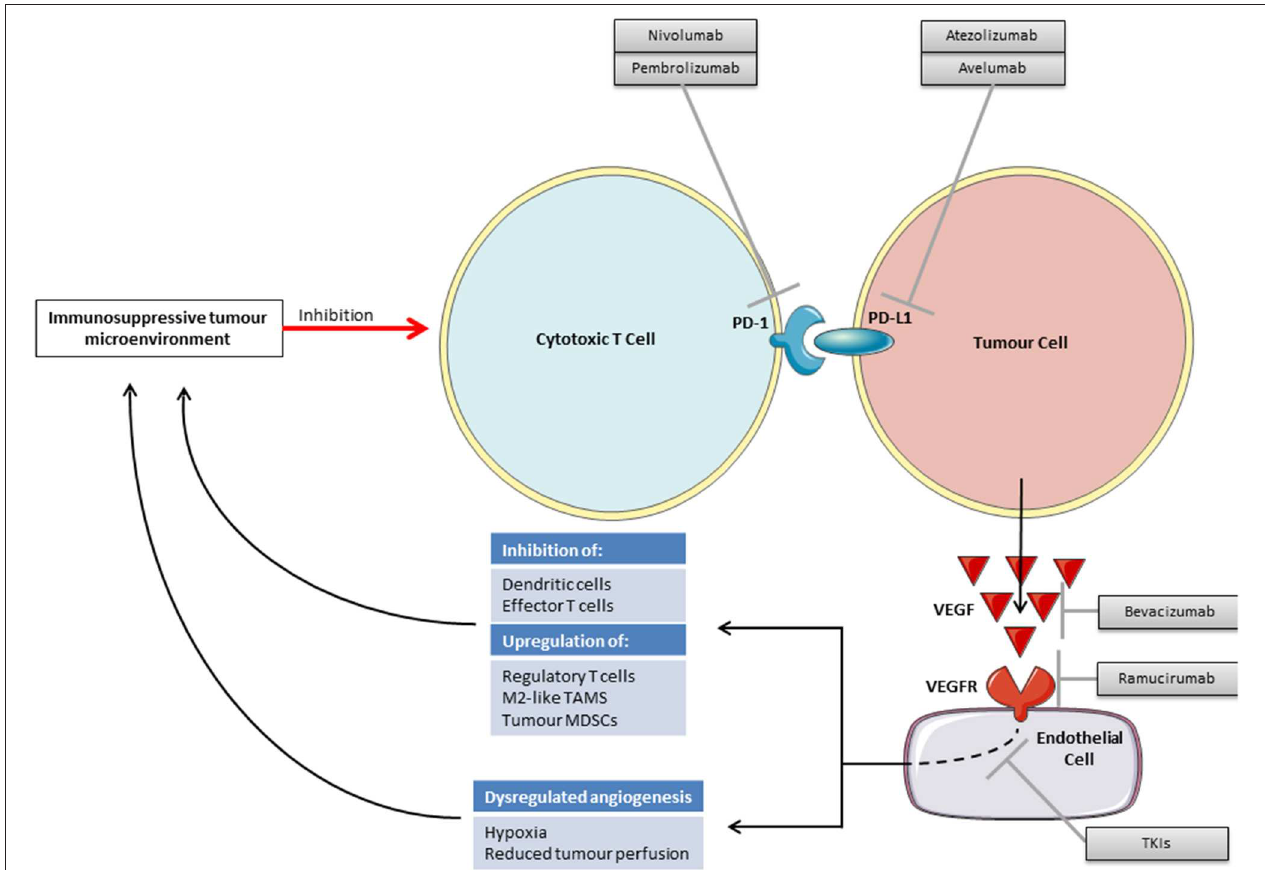
FIGURE 2 | Rationale for combining VEGF inhibition with checkpoint inhibitors.